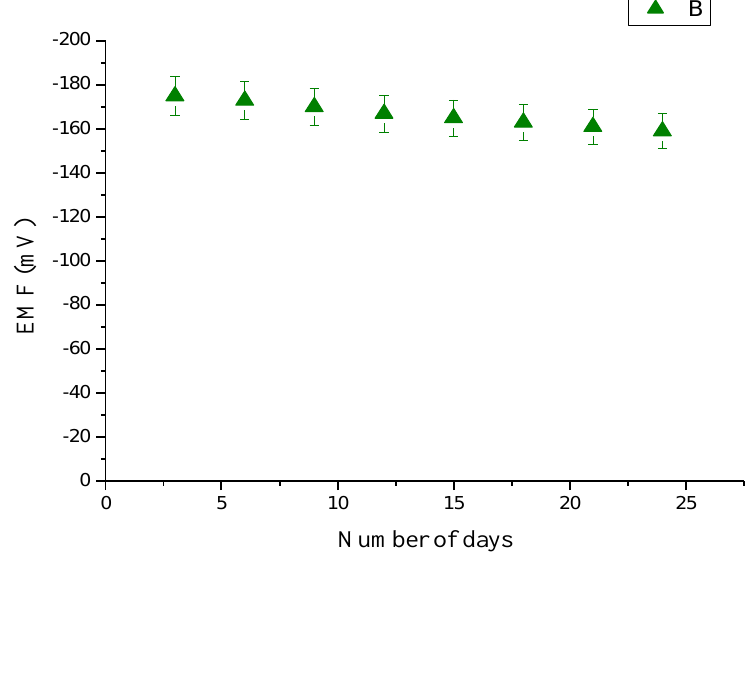
Figure 7. Calibration curve showing the study of the electromotive (EMF) response with the influence of storage at 4 °C for three